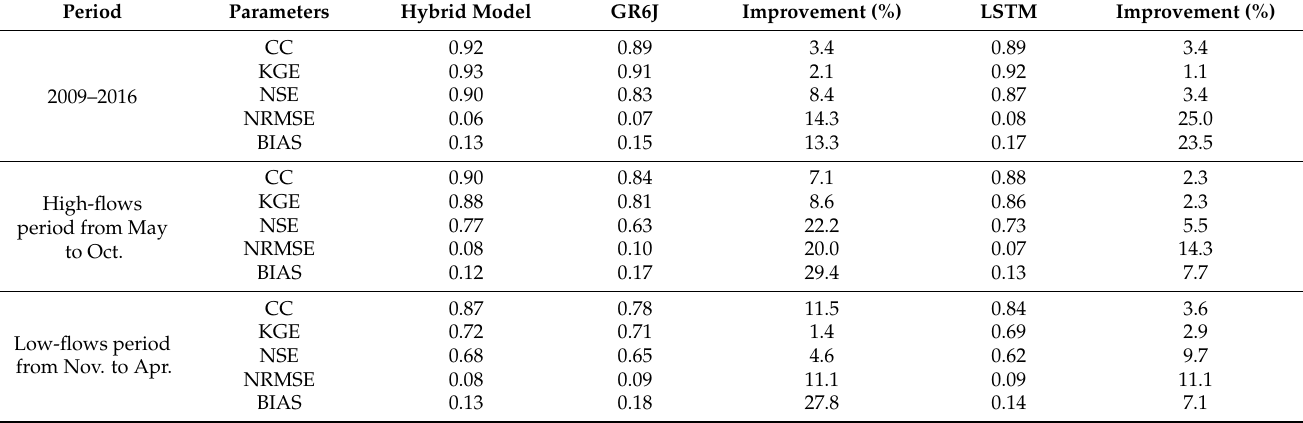
Table 2. Comparison between estimated flow discharges by the GR6J, LSTM and hybrid models at the VS077, and observed discharges at the Huangshigang station during 2009–2016. Period